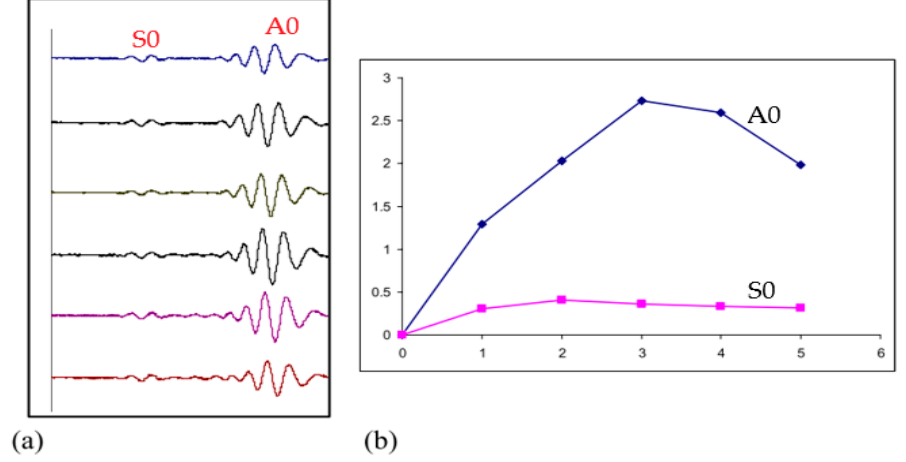
Figure 9. DI analysis on pitch-catch signals for corrosion detection. ( a ) Received signal at PWAS 4 when PWAS 0 sent at 120 kHz; ( b ) DI curves of both A0 and S0 wave packets at 120 kHz of path 0–4 [117].